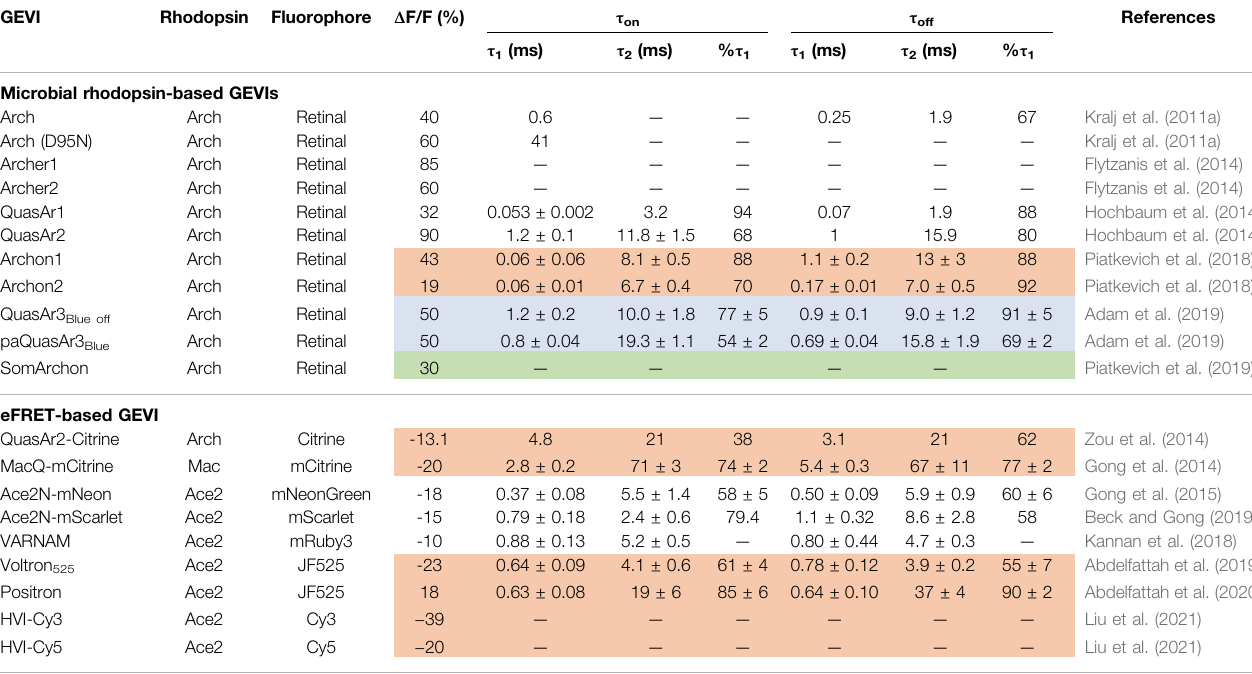
TABLE 1 | Comparative performance of rhodopsin-based genetically encoded voltage indicators. GEVI Rhodopsin Fluorophore Δ F/F (%) τ